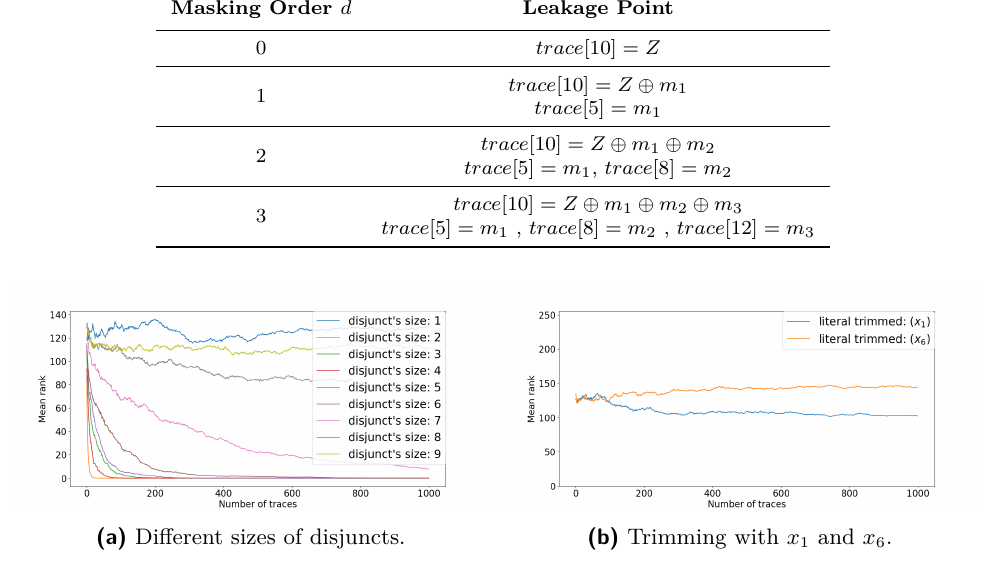
traces for the attack